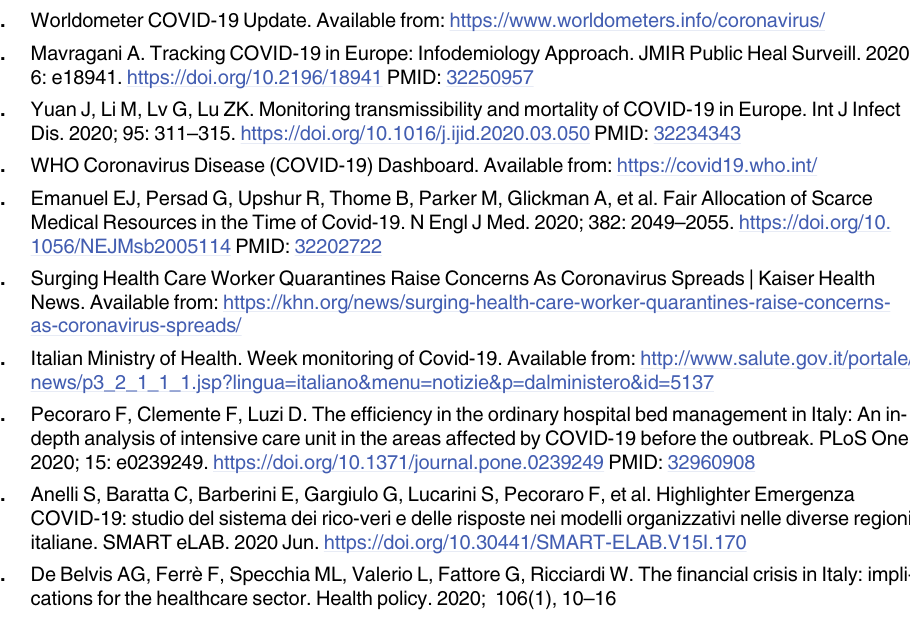
S1 Table. Cross-regional comparison of the results of bed management as well as complex and performance analysis. CMI = Case-Mix Index, PI = Performance Index, TOI = Turn- Over Interval, BOR = Bed Occupancy Rate, BTO = Bed Turn-Over, AvLOS = Average Length of Stay. Green cells specifies values that are within the relevant threshold: CMI > 1, PI < 1, 3 < TOI < 1, 75% < BOR <